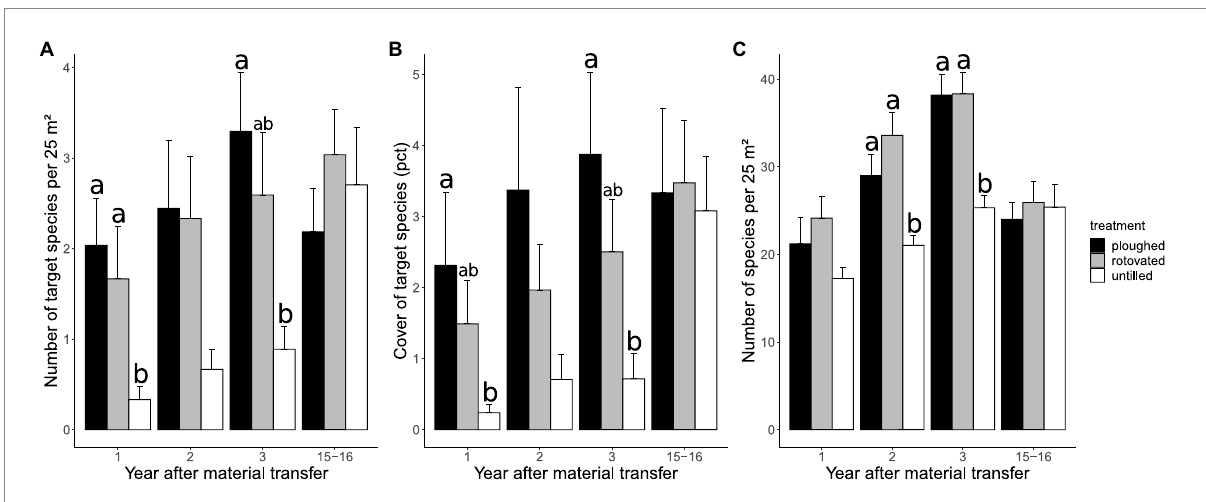
FIGURE 1 Development of the number (A) and cover (B) of target species and the number of species (C) per 25 m 2 over time after the transfer of plant material on the previously studied restoration sites for the three different treatments ploughed, rotovated, and untilled ( n = 9, respectively). Significant differences within years ( p < 0.05, ln-transformed data) are indicated by different letters above the bars. Whiskers refer to the standard errors.